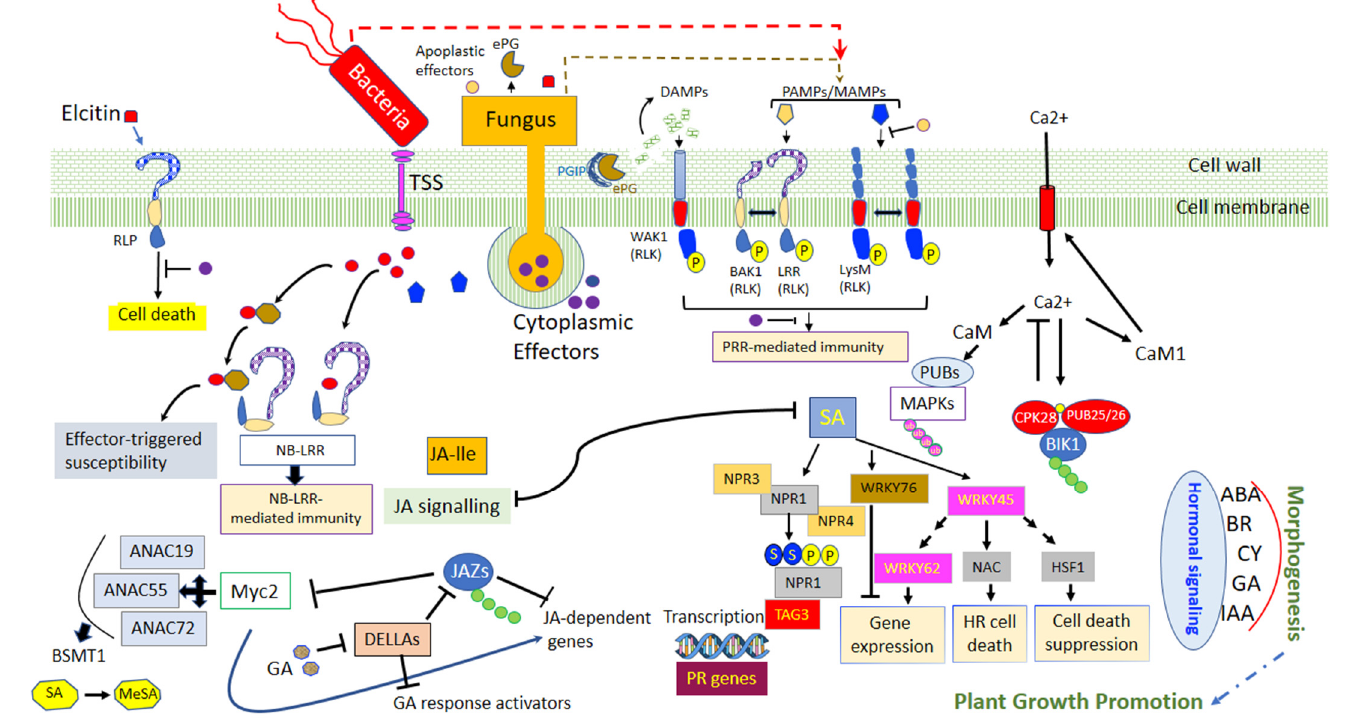
Figure 2. Insights into some molecular factors in plant-pathogen interactions that may be involved in plant immunity. The perception of host damaged-associated molecular patterns (DAMPs), resulting from the interaction between endo-polygalacturonases (ePGs) secreted by some fungi and the PG-inhibiting proteins (PGIPs) secreted by the plant, through DAMP receptors (such as, DAMP receptor wall-associated receptor kinase 1 (WAK1)) triggers plant defense responses. Additionally, microbe-associated molecular patterns (MAMPs) are delivered from microbes to the apoplast (apoplastic effectors) or delivered inside host cells (cytoplasmic effectors) to perturb plant cell physiology. The MAMPs may be perceived by the cell surface pattern-recognition receptors (PRRs; receptor- like kinases (RLKs) or receptor-like proteins (RLPs)) and triggers downstream phosphorylation cascades and provoke an enhancement of [Ca 2+ ] and reactive oxygen species (ROS). The activation of pathogen-responsive MAPK cascades is one of the earliest signaling events in PTI and ETI. The pathogen effectors are recognized by intracellular receptors, nucleotide binding site-leucine-rich- repeat (NLRs also known as NB-LRRs), triggering therefore downstream responses including Salicylic acid (SA) accumulation. The results of defense signaling involve modulation of gene expression, the synthesis of (PR) proteins, and biosynthesis of antimicrobial metabolites. More details in the main text. Ub, Ubiquitin. P, phosphate group. S, Small ubiquitin-like modifiers; ABA, Abscisic acid; BR, Brassinosteroid; CAM, Calmodulin; CPK, Calcium-dependent Protein Kinases; CY, Cytokinins; GA, Gibberellic acid; HR, Hypersensitive response; IAA, Indol acetic acid; JA-Ile, Jasmonoyl–isoleucine; JAZ, Jasmonate-zim-domain protein; LysM-RLK, Lysin motif receptor-like kinases; MAPKs, Mitogen- activated protein kinase; NPR, Nonexpressor of pathogenesis-related genes; PUB, Plant U-box; T3SS, type III secretion